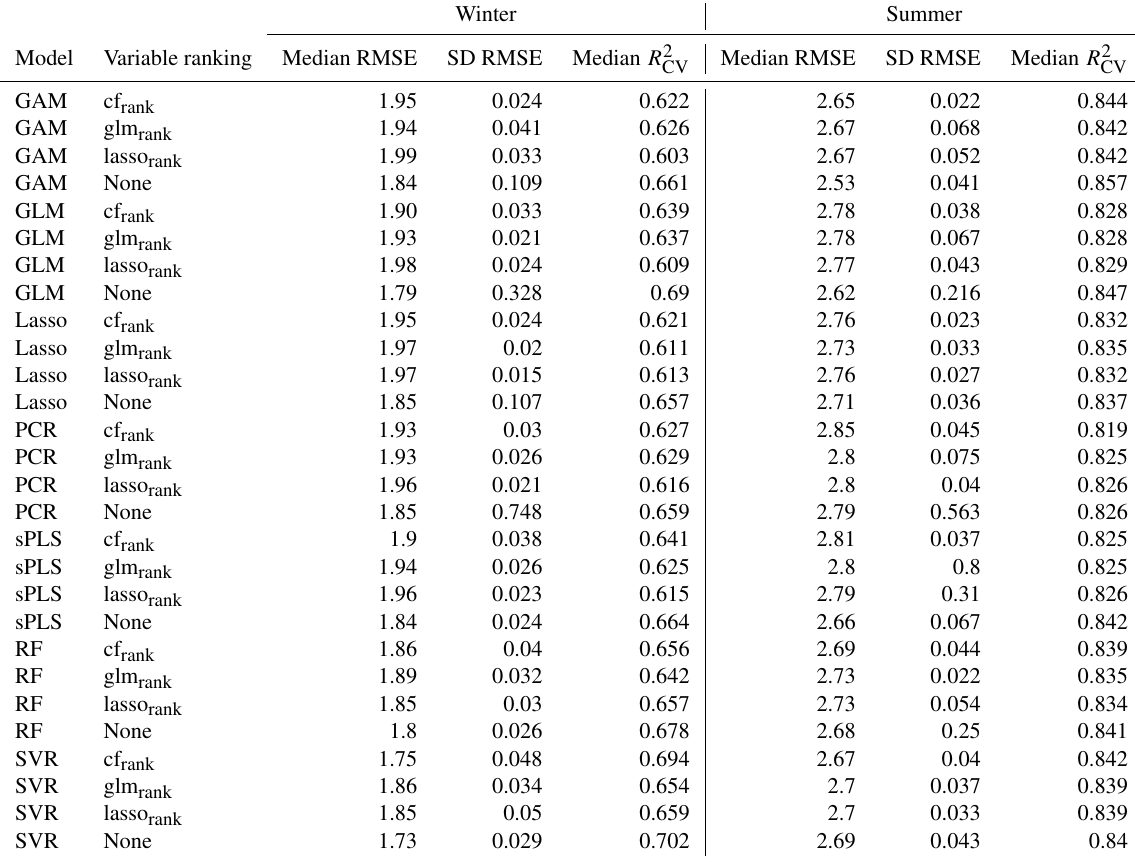
Table 2. Overview of the prediction performance of all the models. The median and standard deviation (SD) are calculated over the 10 CV runs for each